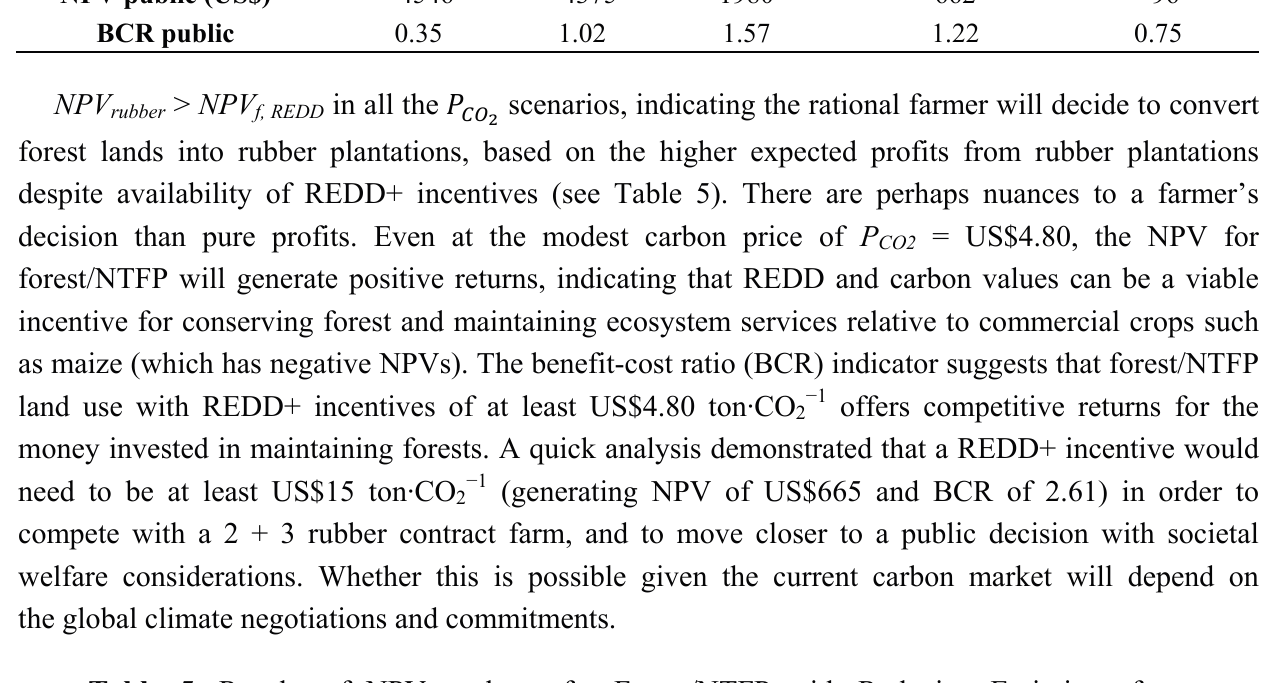
Table 5. Results of NPV analyses for Forest/NTFP with Reducing Emissions from Deforestation and forest Degradation (REDD+)